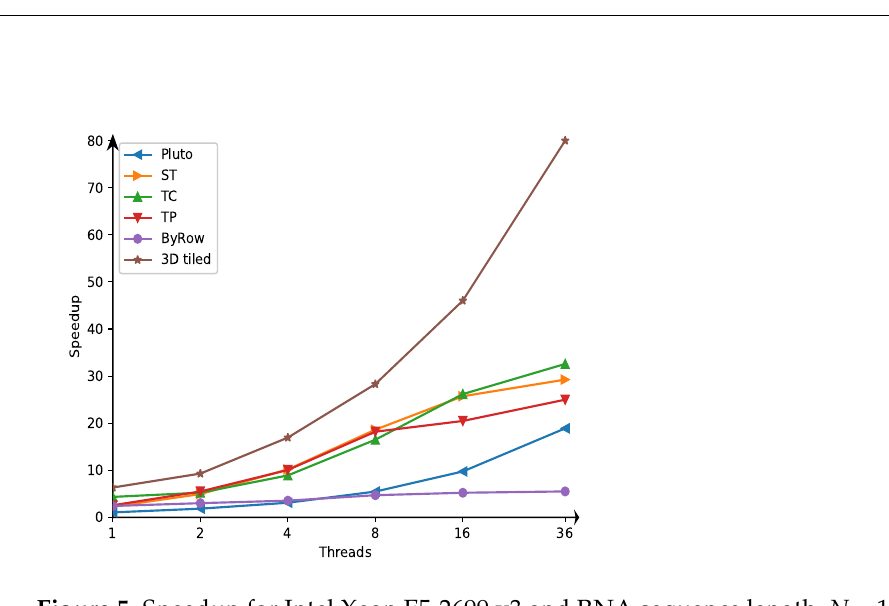
Figure 5. Speedup for Intel Xeon E5-2699 v3 and RNA sequence length, N =